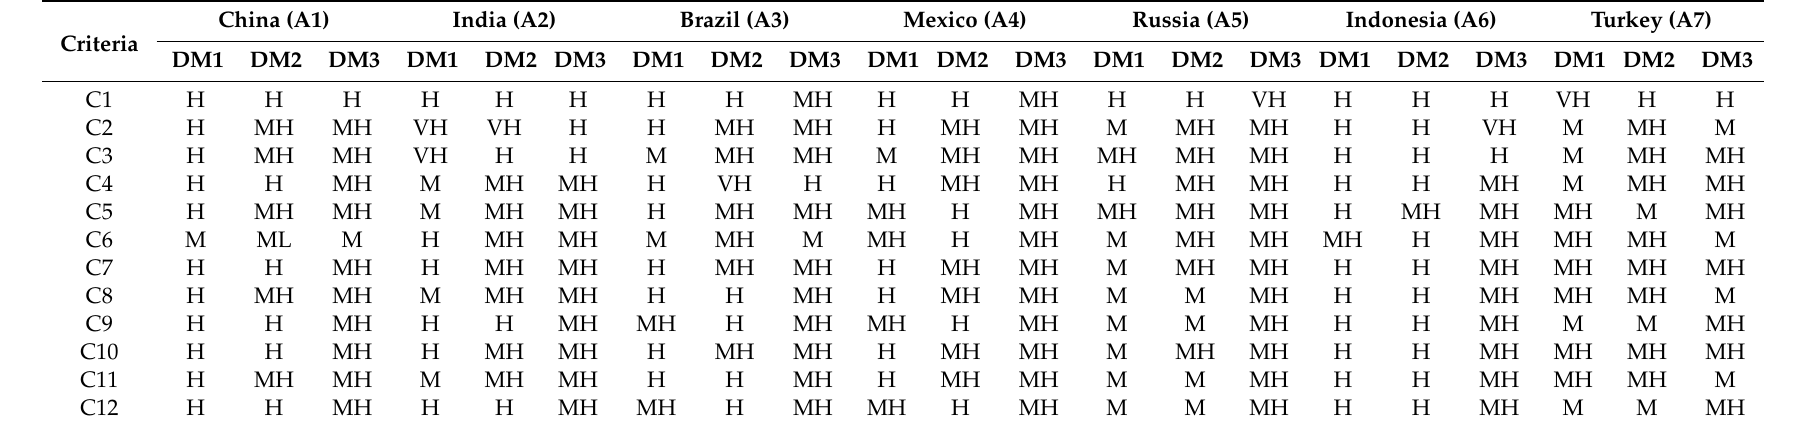
Table 8. Linguistic evaluations of the E7